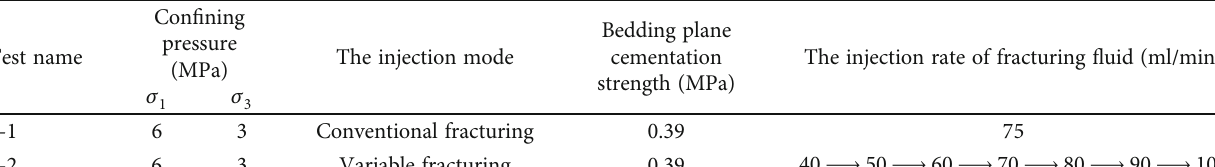
Table 5: Experimental scheme for hydrofracturing under di ff erent injection